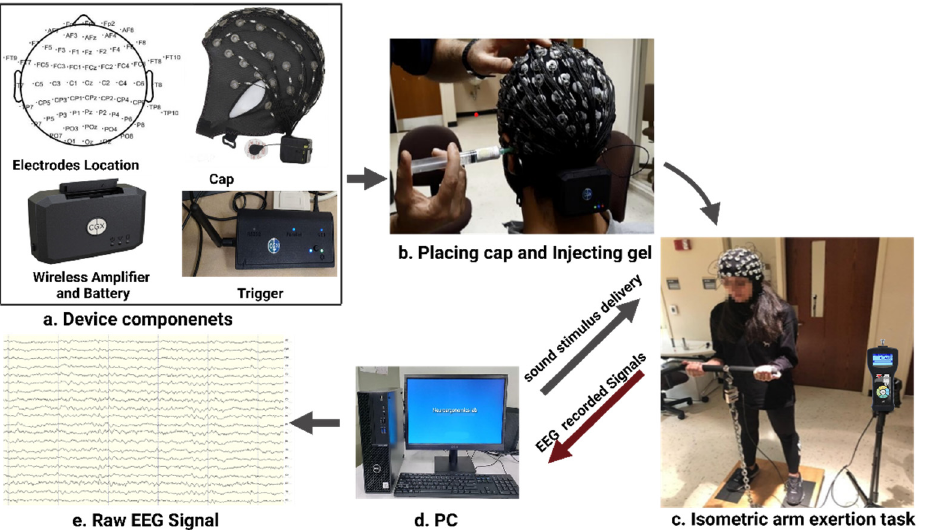
Figure 4. EEG data acquisition system and its components. ( a ) D evice components. ( b ) Placing cap and injecting gel. ( c ) Isometric arm exertion task. ( d ) PC. ( e ) Raw EEG Signal. and injecting gel. ( c ) Isometric arm exertion task. ( d ) PC. ( e ) Raw EEG